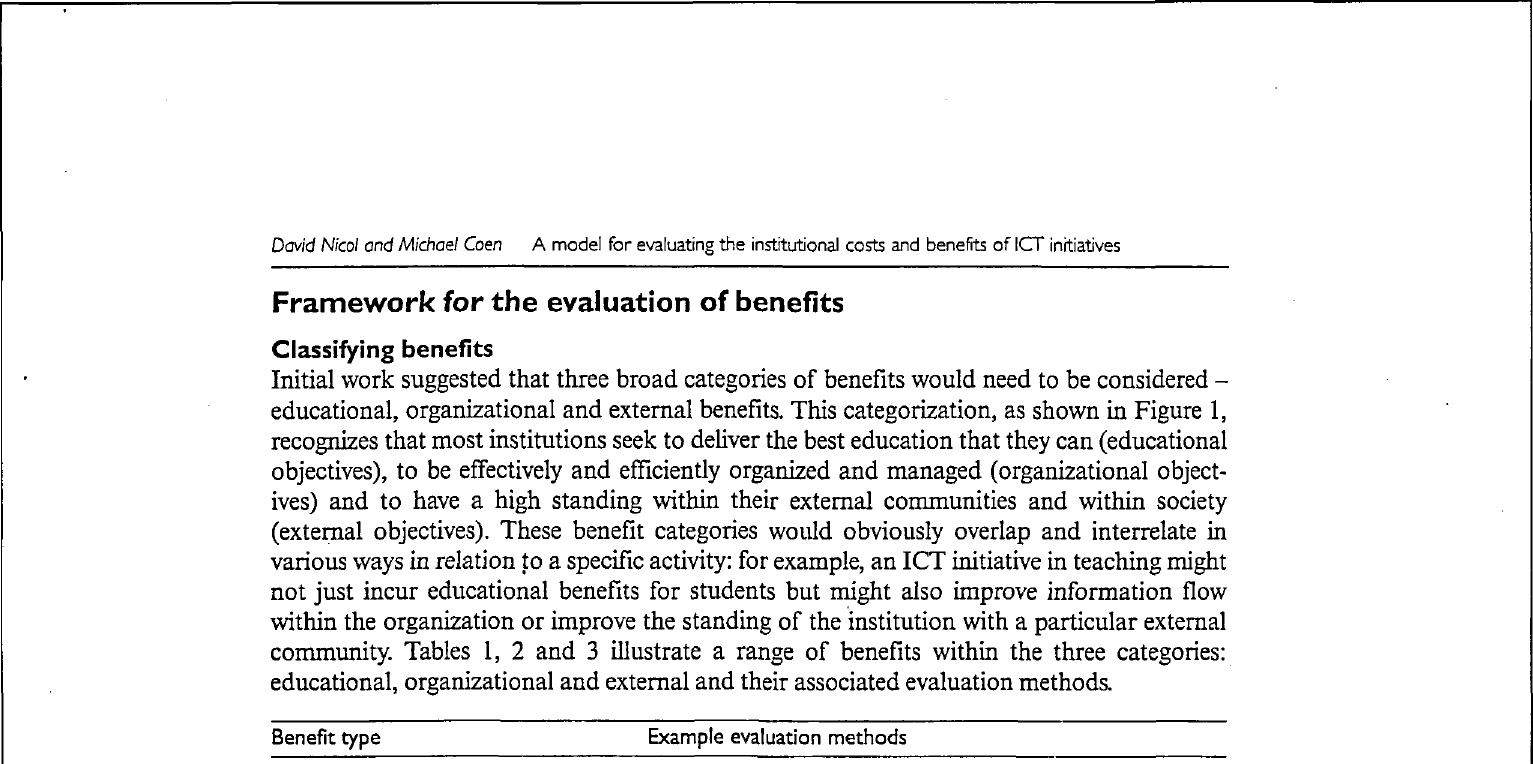
Table I: Educational benefits and example evaluation methods Benefit type